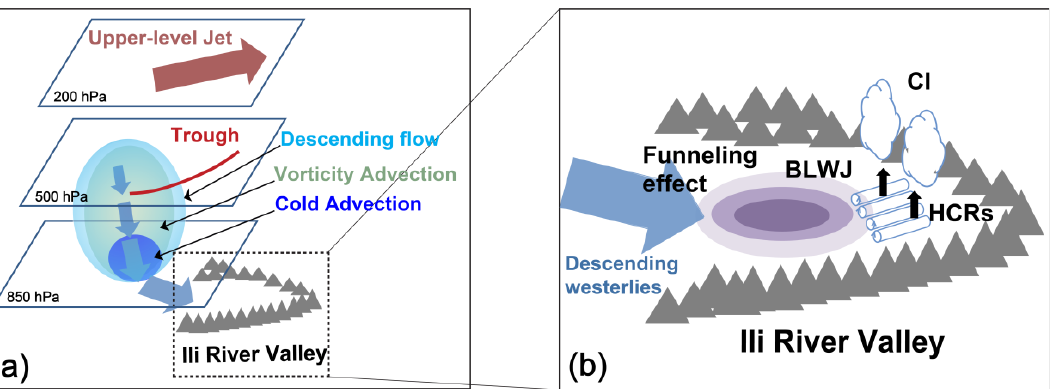
Figure 15. Schematic model summarizing mechanism of the CI process in Ili River Volley. ( a ) and ( b ) indicate the synoptic- and meso-scale environmental characteristics, respectively. Gray triangles indicate the Tianshan mountain.